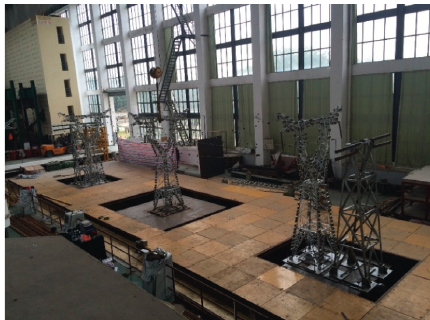
Figure 10: Physical components used for the five-tower-four-line